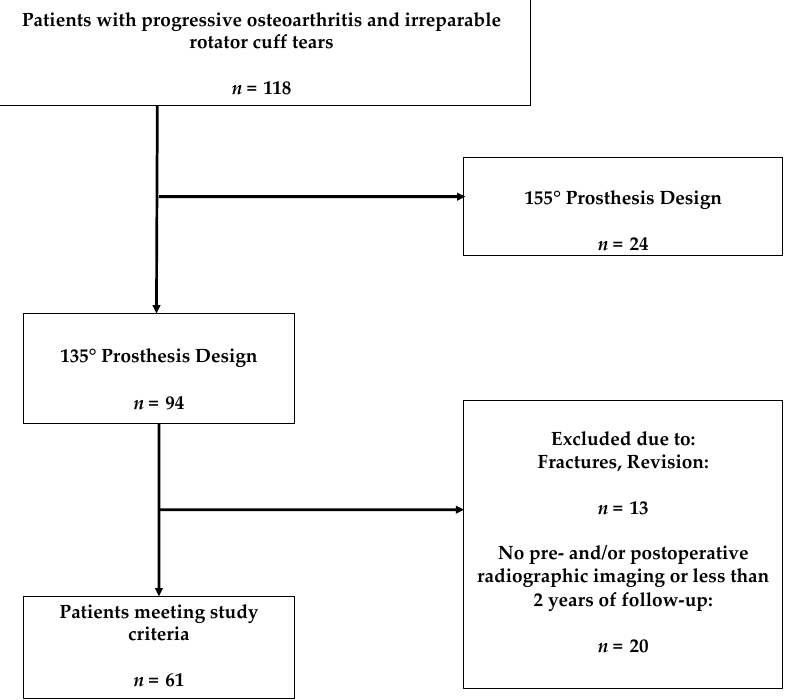
Figure 6. Flowchart displaying inclusion criteria . Table 1. Patient demographics ( N = 61).